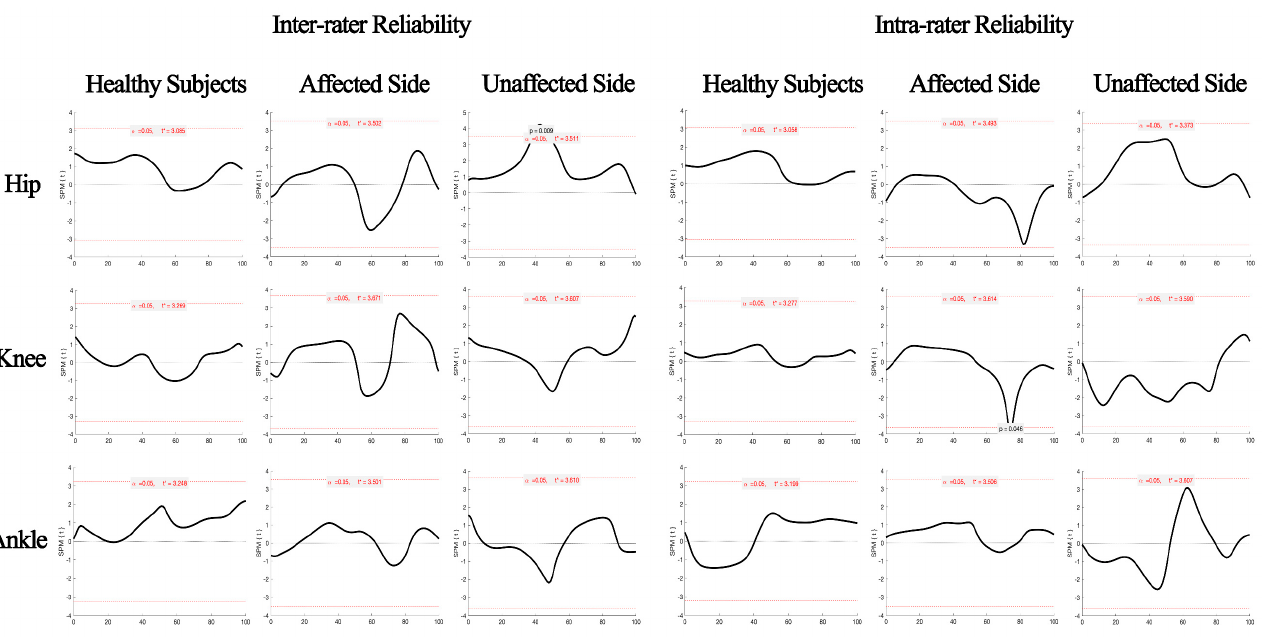
Figure 4. The SPM results of the inter/intra − rater reliability of the Odonate system for lower limb kinematics. Table 2. CMC results of the Odonate system in lower limb